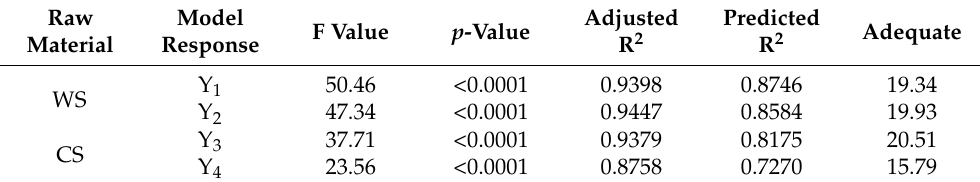
Table 5. ANOVA analysis of the model’s